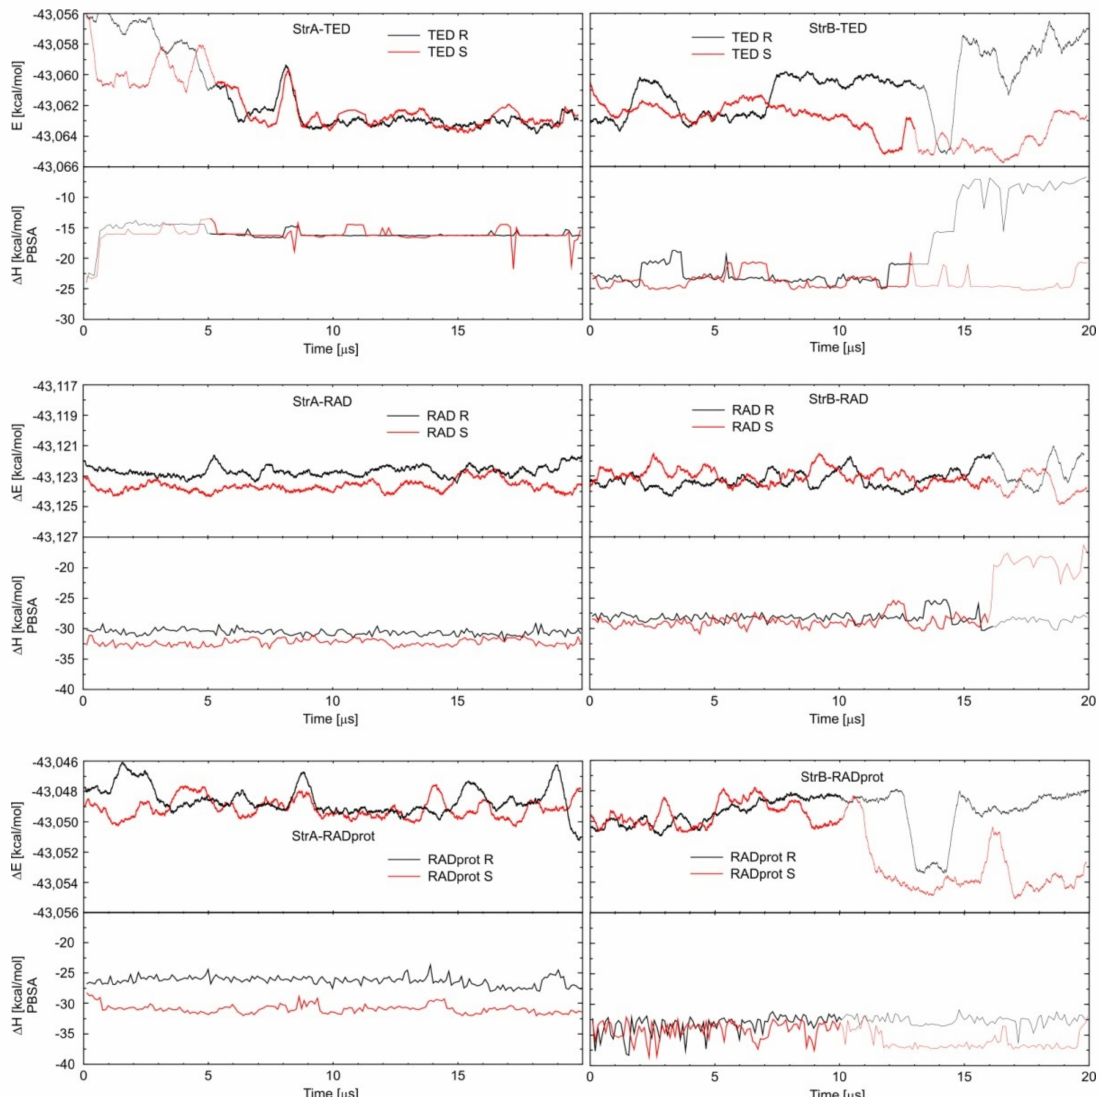
Figure 4. Energy changes during molecular dynamics simulations. The simulation ranges from which the average energies were calculated are shown in bold in Table